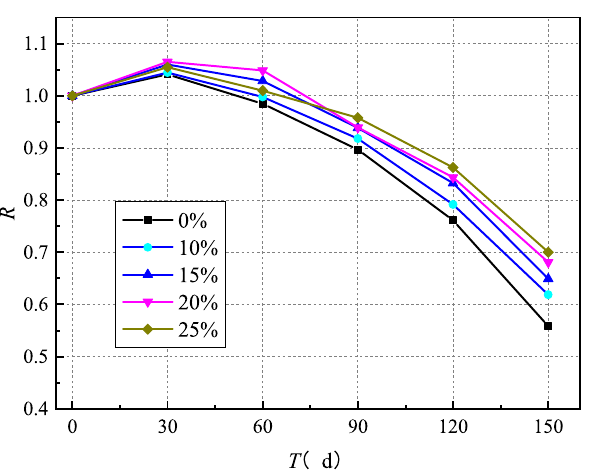
Figure 3. Loading device schematic diagram.